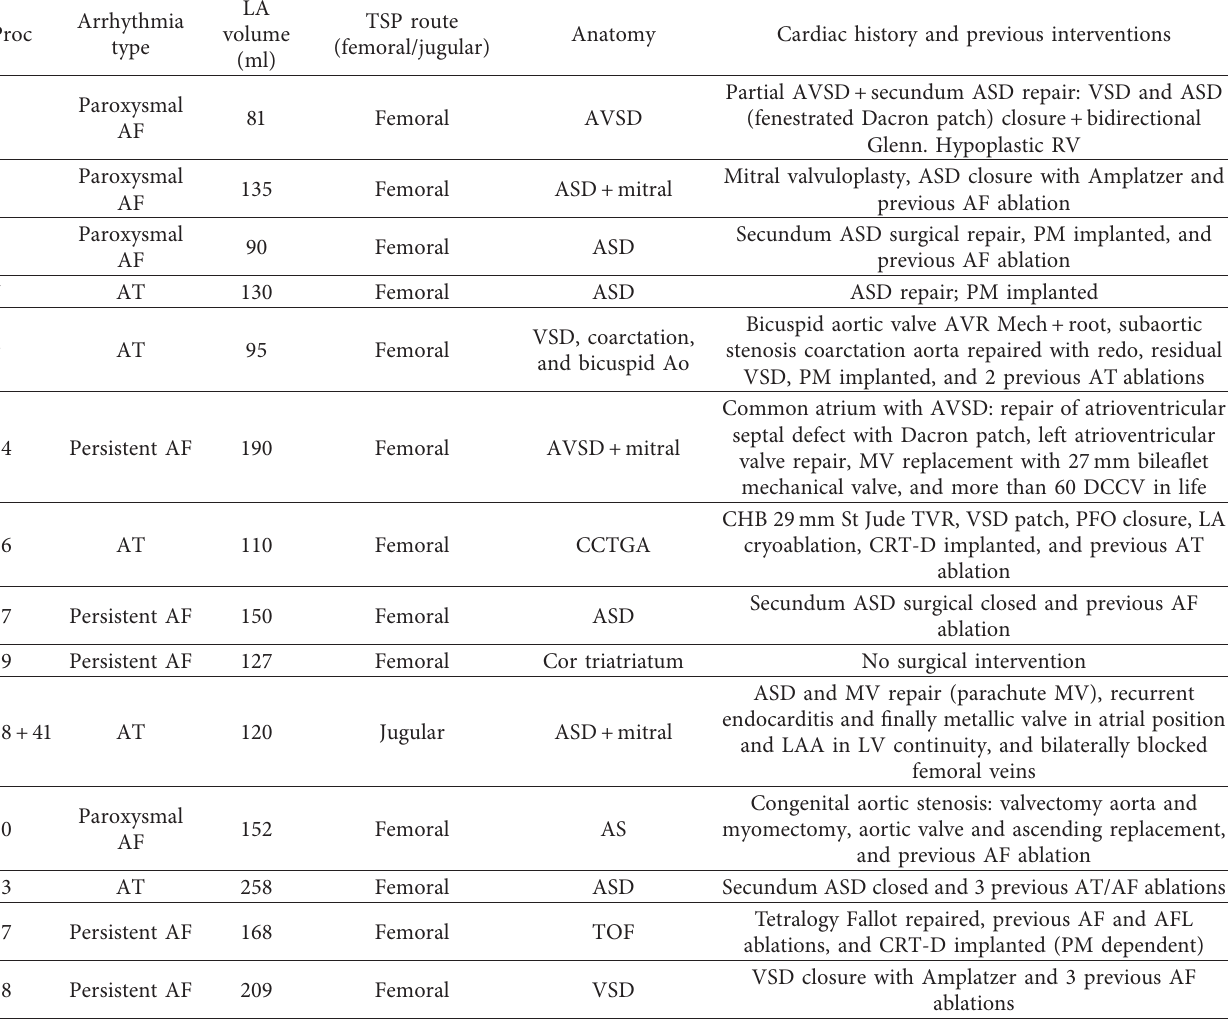
Table 2: Cases description for CHD conditions.